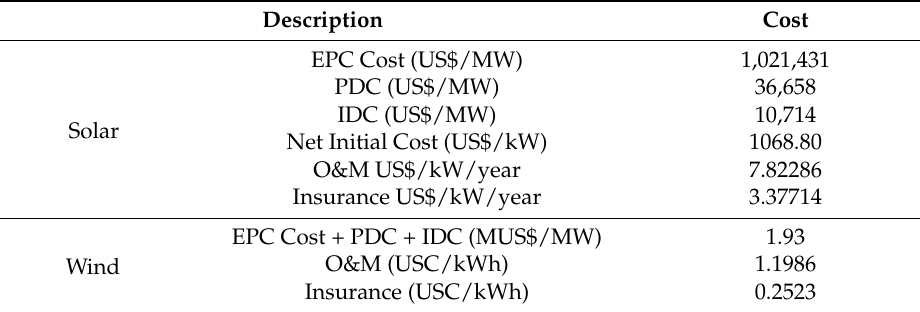
Table 3. Cost parameters of Solar and Wind [51].